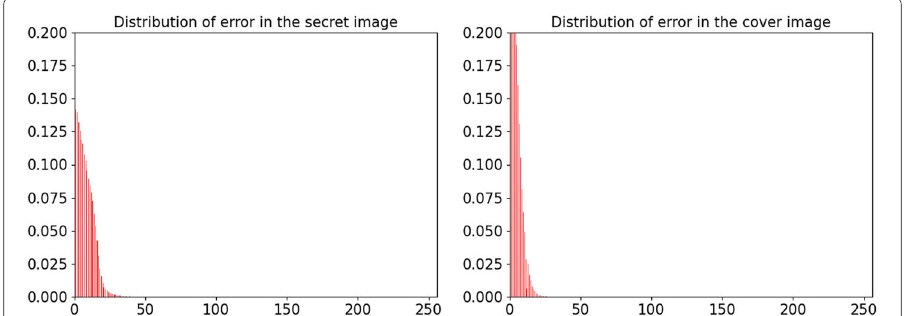
Fig. 7 The distribution of pixel errors for 3-channel cover images and secret images, respectively. The horizontal axis of the histogram represents the value of the pixel error, and the vertical axis represents the frequency of the corresponding pixel